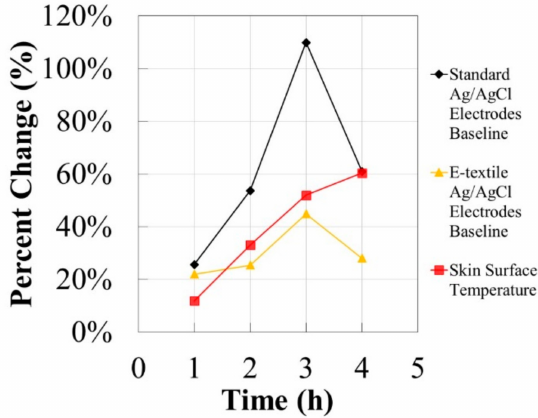
Figure 10. The signal percent difference of the skin surface temperature, standard electrode baseline EDA signal, and e-textile baseline EDA signal from the beginning of the test and at each hour time point ± 10